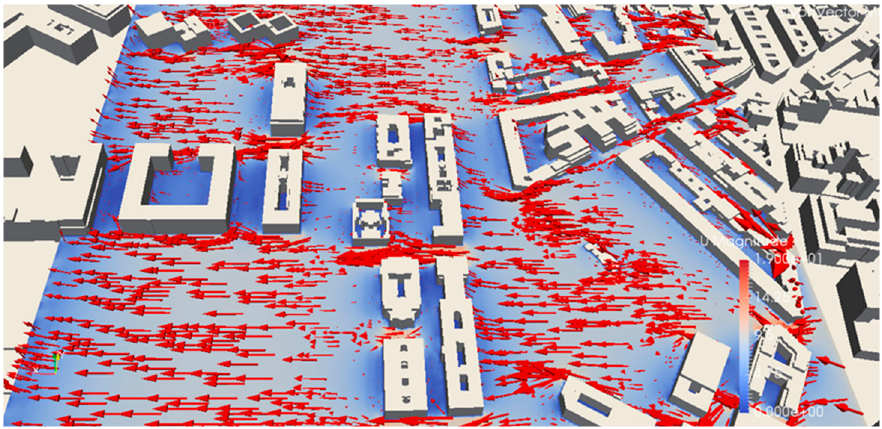
Figure 7. Streamlines of the flow field at University of León.